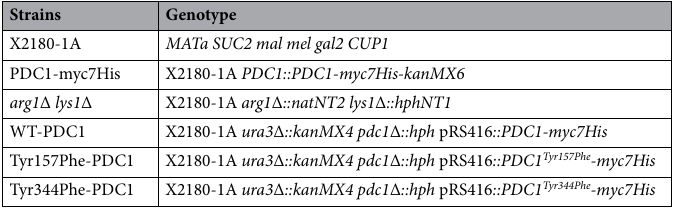
Table 2. Yeast strains used in this